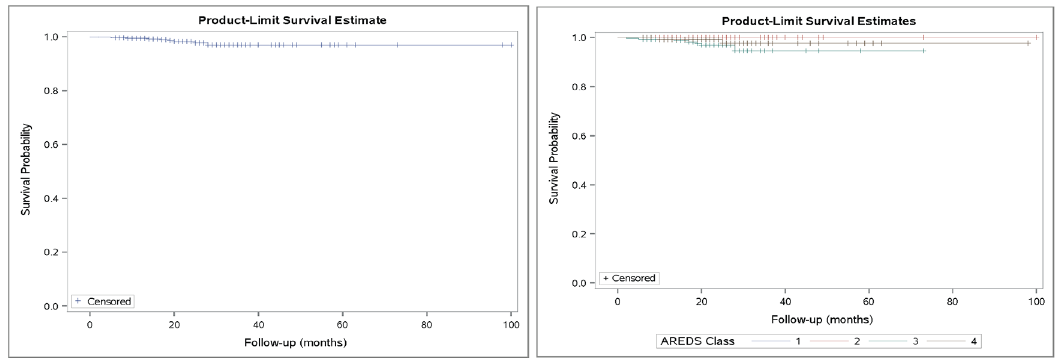
Fig 1. Kaplan-Meier plots showing the event probability across follow-up time overall (left) and by ARED category. The steps down on the curve indicate the CNV cases, while the notches indicate censorship, when follow-up ended for non-cases.